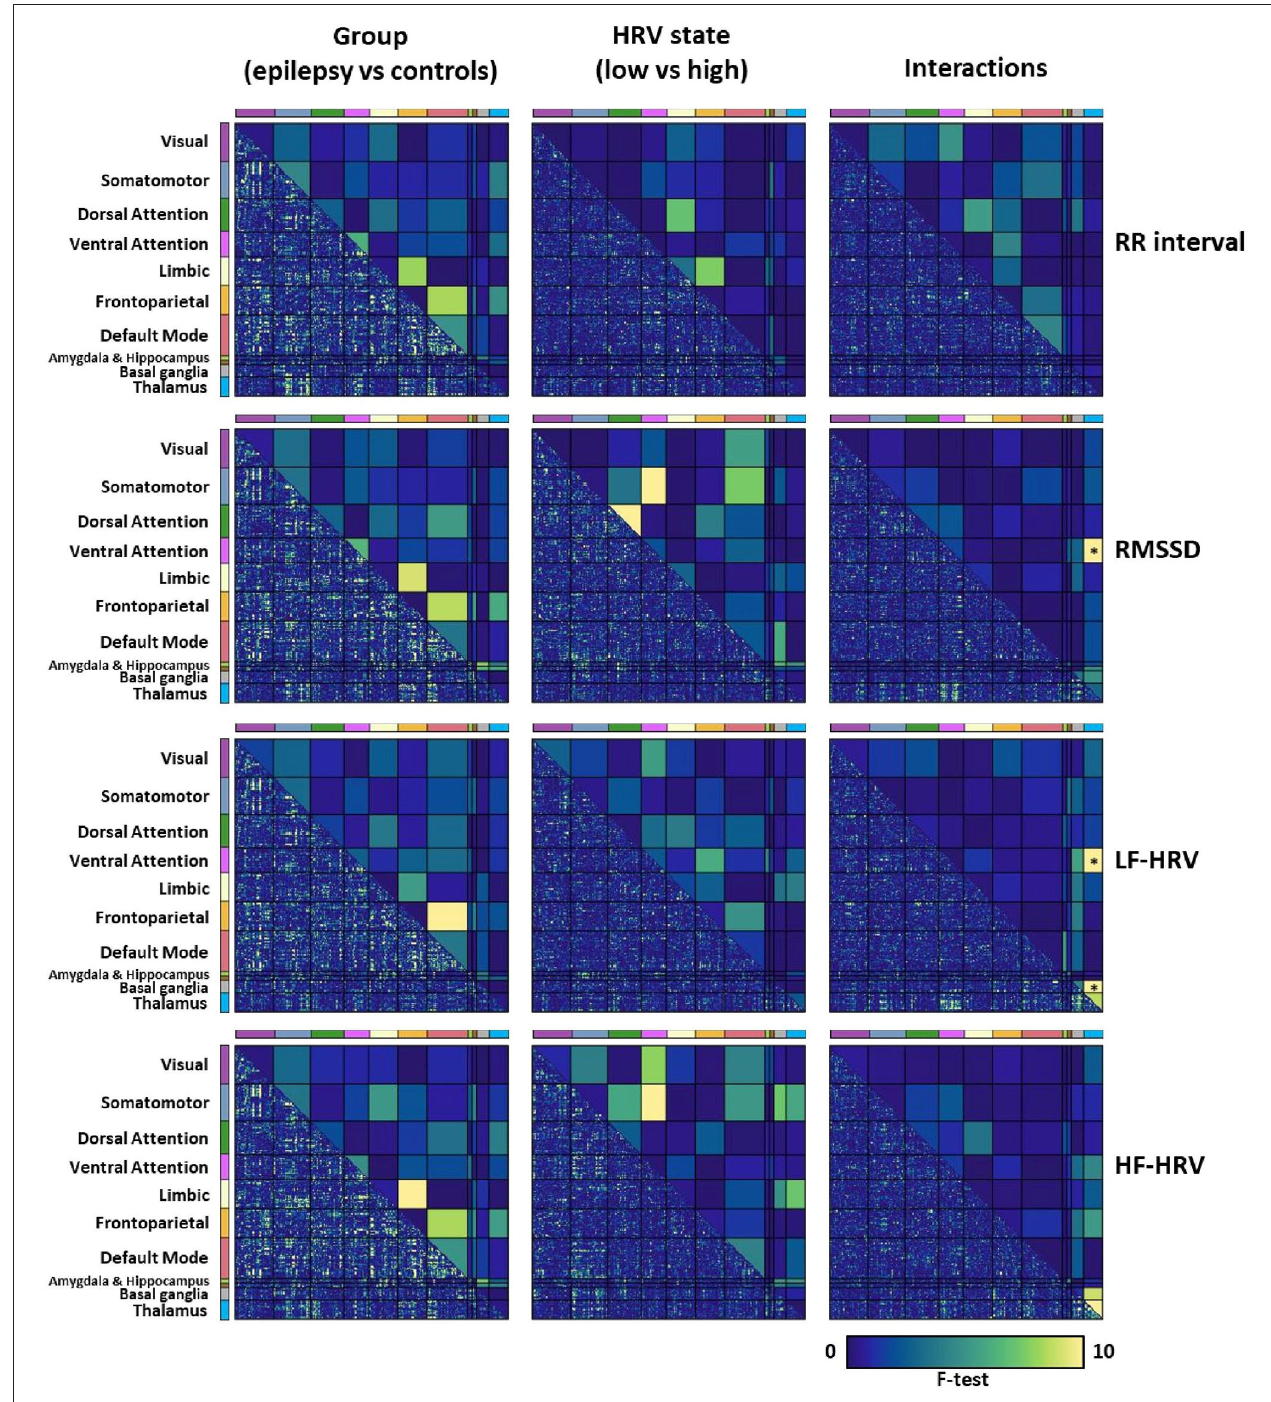
FIGURE 3 | Mixed analysis of variance (ANOVA) for evaluating the effects of the group (epilepsy vs. controls; 1st column) and HRV state (low vs. high, patients and healthy controls; 2nd column) on whole-brain connectivity, and their interactions (3rd column). The lower triangular matrix corresponds to the f -test for pairs of parcels whereas the upper triangular matrix corresponds to the f -test for pairs of the eleven networks. The connectivity strength between pairs of networks that was used in the mixed ANOVA was defined as the mean correlation averaged across all pairs of parcels that belonged to the two corresponding networks. Pairs of networks with p < 0.0125 after FDR correction are indicated with an asterisk (*). Note that the lower triangular matrices are only shown to provide a qualitative description of the interactions of networks at the parcel level, and that their significance levels are not assessed. We observe that the connectivity strength of the thalamus with the ventral attention network and basal ganglia has strong interactions between the group and the LF-HRV state, which led us to examine thalamic connectivity with the ventral attention network and basal ganglia more carefully.